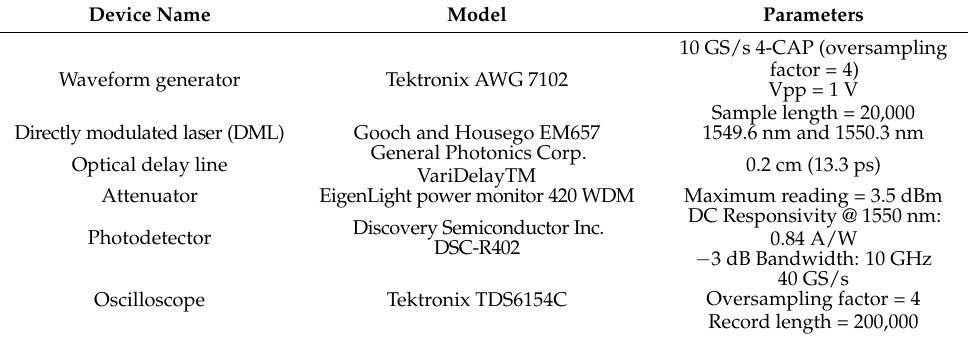
Table 1. Physical parameters of the experimental